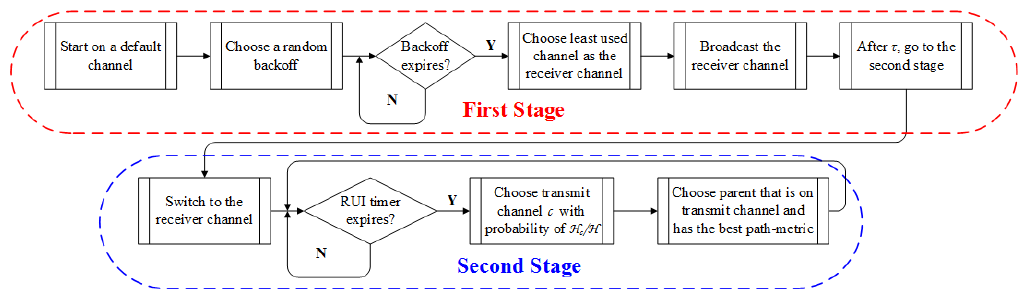
Figure 8. Conceptual diagram of